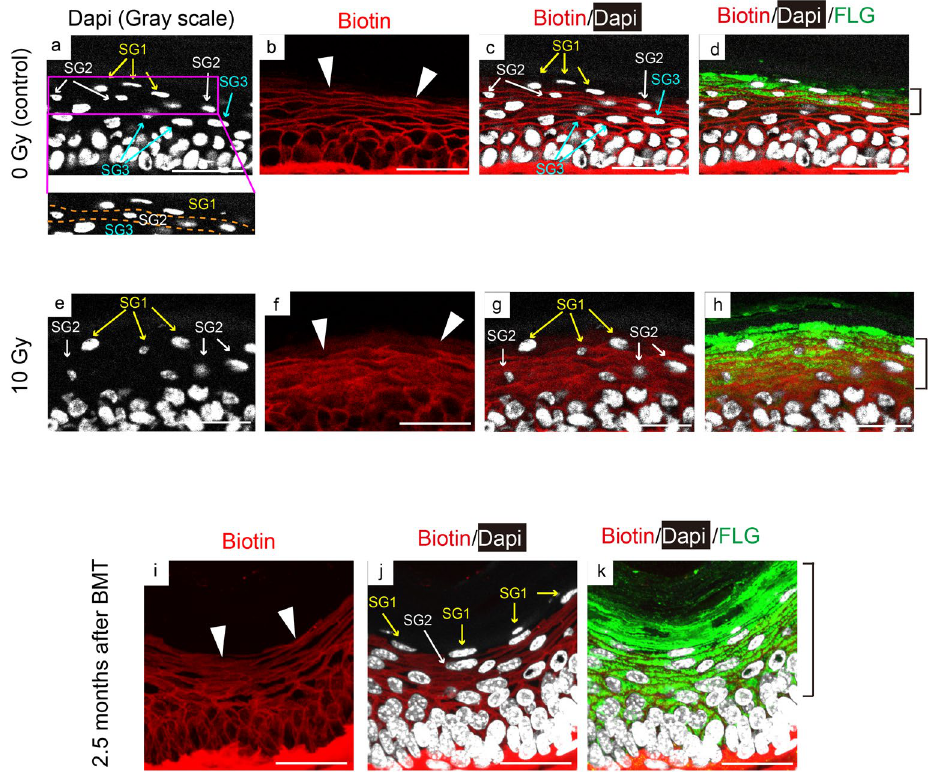
Figure 1. BMDCs block IR-induced skin barrier defects. Histological images of the paw pad skin of control ( a – d ) and 10 Gy- ( e – h ) irradiated mice 7 days after IR are shown. High-power view ( a ) shows the alignment of granular layers (SG1-3) using orange dotted lines. Biotin tracer (red) injected dermally is visualized with DAPI (greyscale) and staining with anti-filaggrin (FLG; green). ( i – k ) Biotin staining and merged staining (biotin and filaggrin with DAPI) of the paw pad skin of mice receiving allogeneic bone marrow transplantation (BMT) after 10 Gy irradiation. The skin 2.5 months after BMT was shown. Arrowheads indicate individual biotin stain patterns, while brackets show the filaggrin-positive layers. Scale bars, 20 µm. IR, ionising radiation; BMDCs, bone marrow-derived cells; BMT, bone marrow